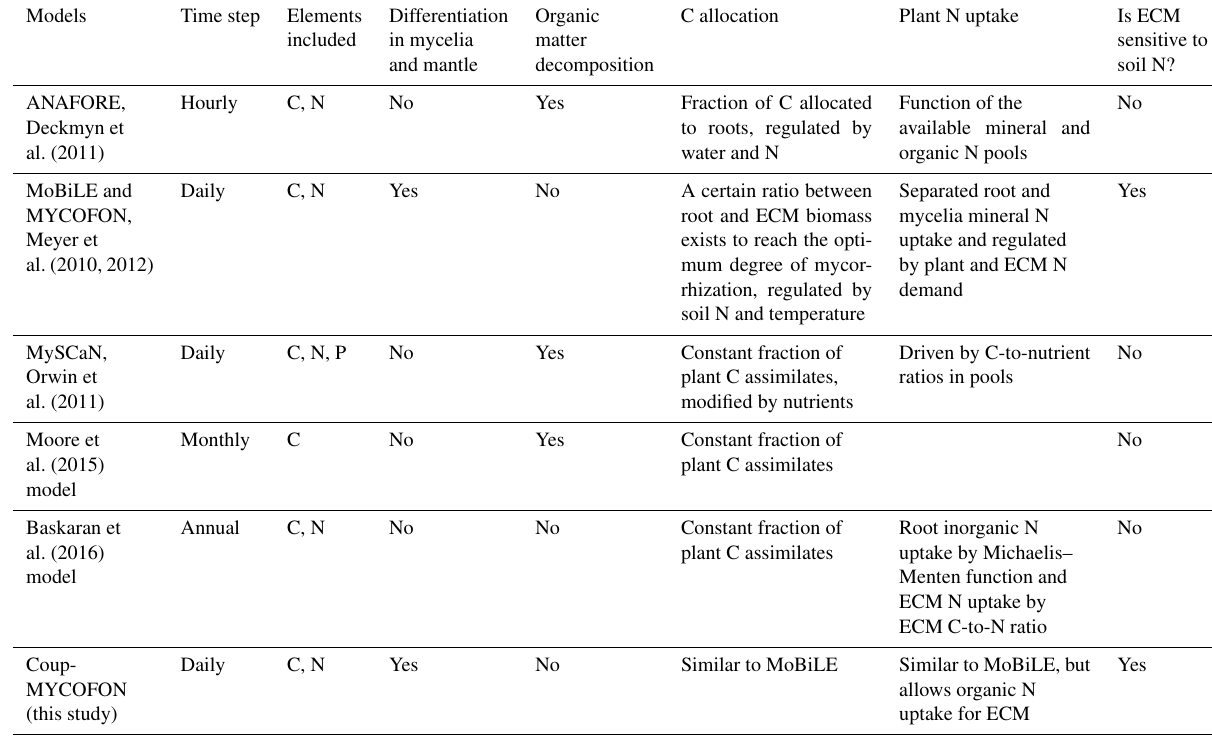
Table 1. Main characteristics of previous ecosystem models that include ECM.